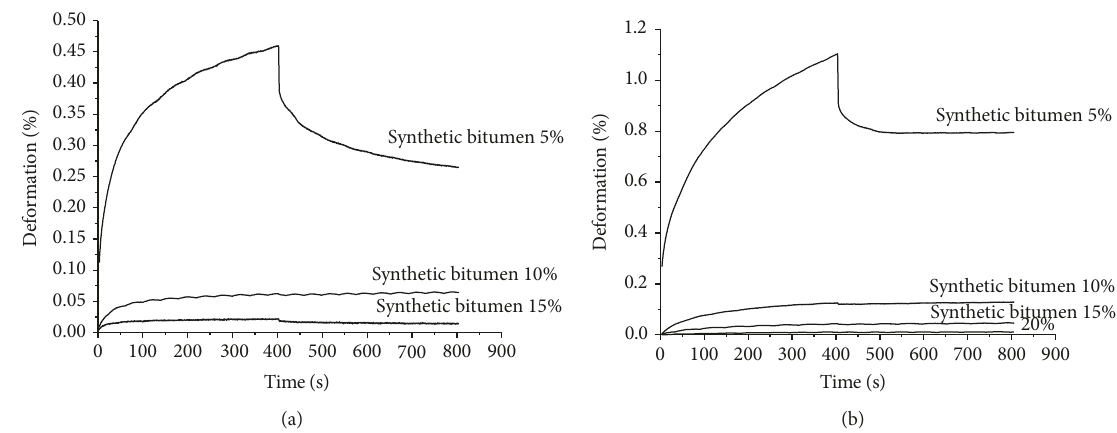
Figure 4: Creep-recovery tests for synthetic bitumen composition at (a) 25 ° C and (b) 50 ° C.